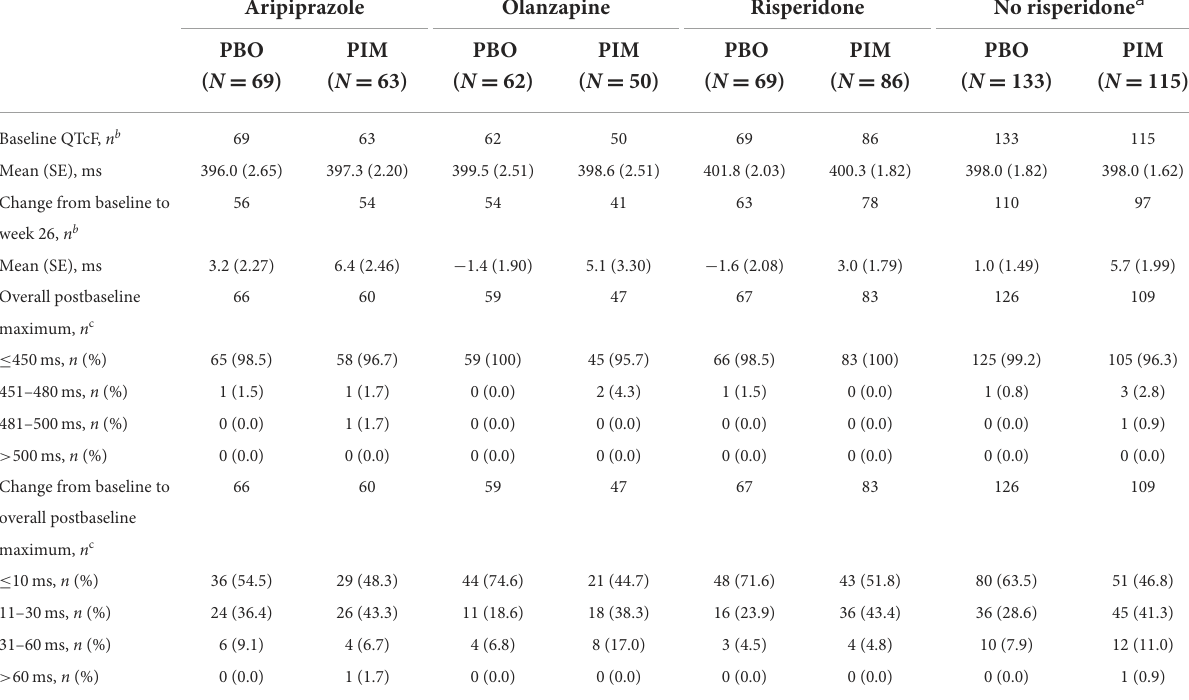
TABLE 3 ADVANCE: QTcF at baseline and on-study.